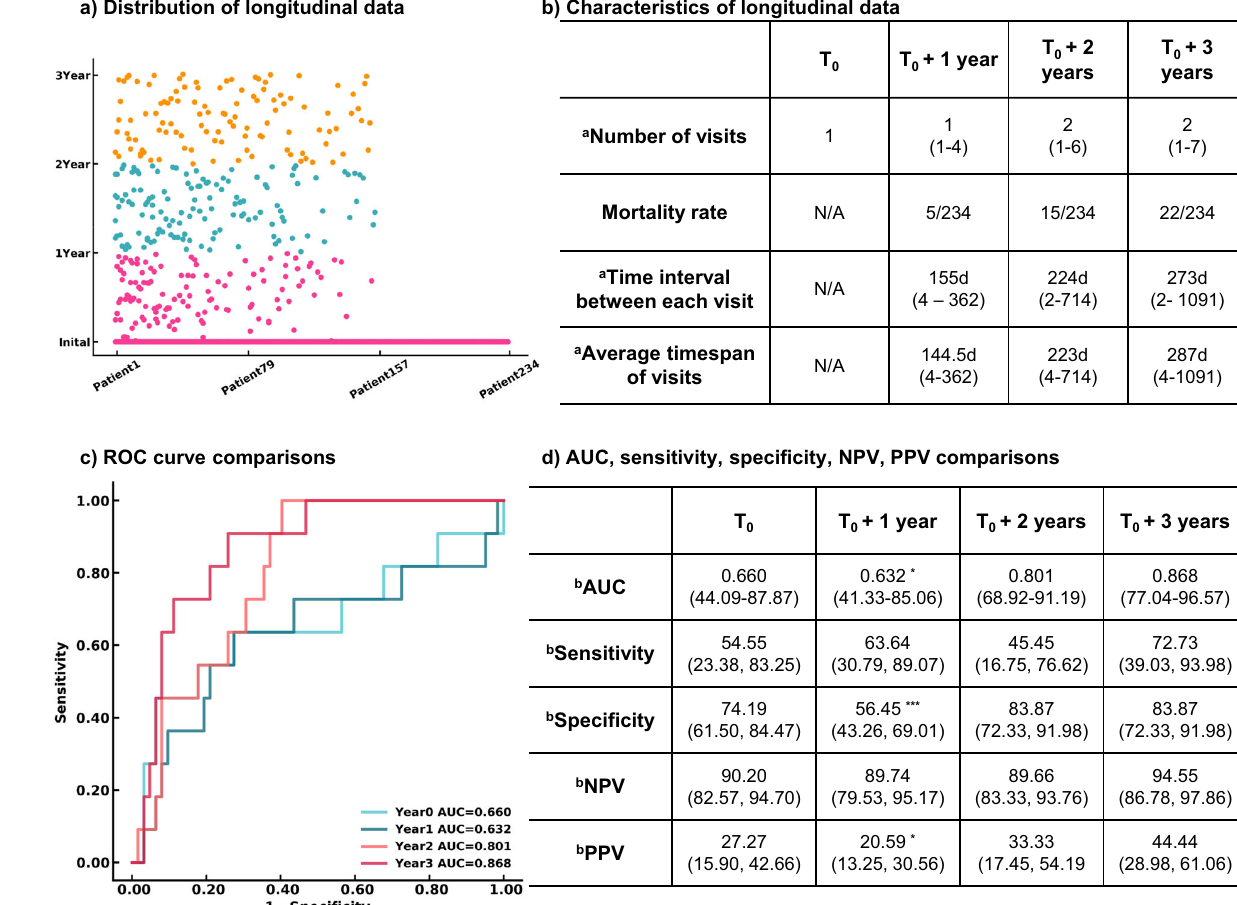
comparison of Transformer models developed at multiple endpoints. n =234 for 3-year survival analysis. Two-sided P -values were calculated for all comparisons. a Data in parentheses indicate the range. b Data in parentheses indicate 95% CI. *** p <0.001. ** p <0.01. * p